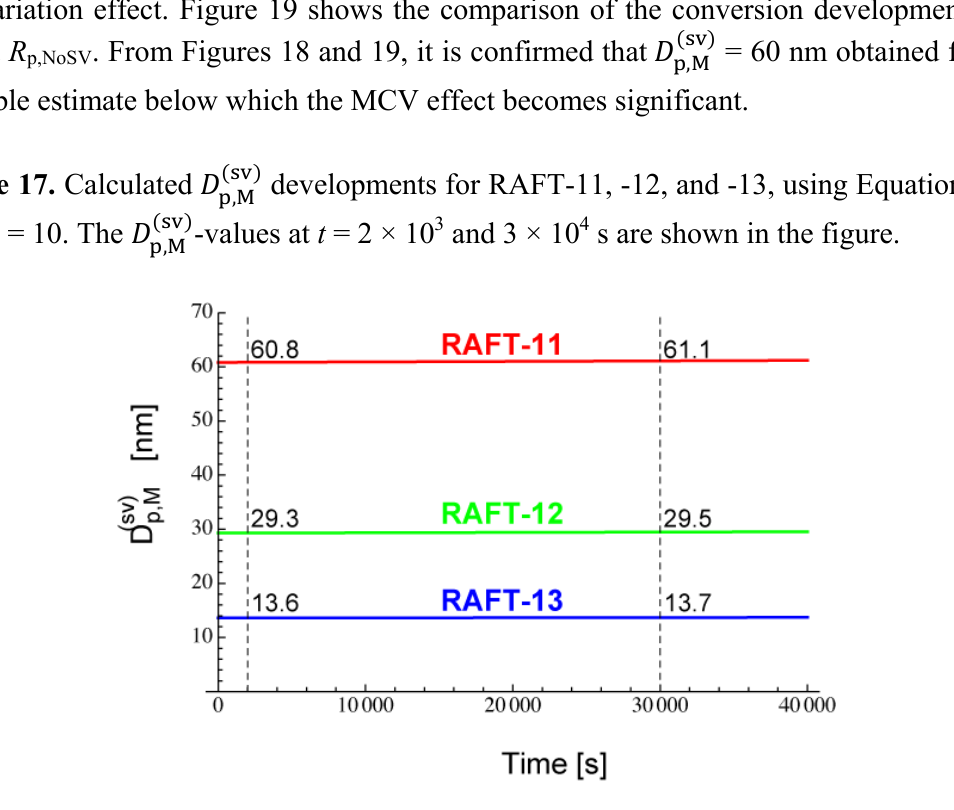
and the polymerization rate p